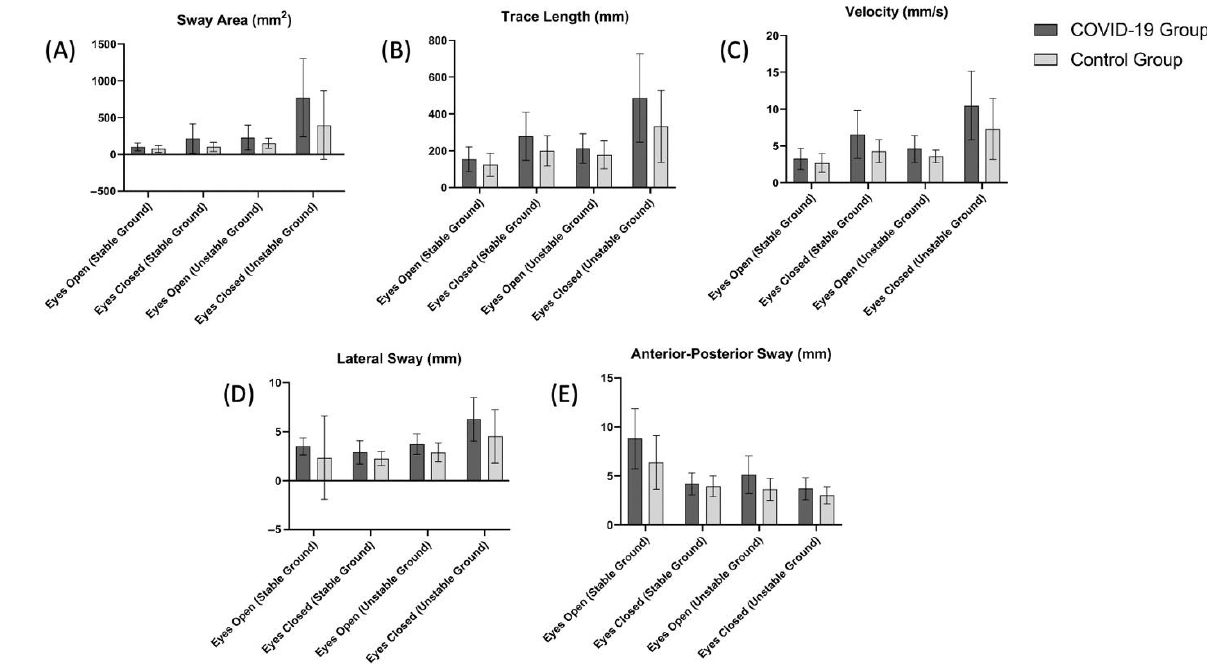
Figure 3. Comparison of ( A ) sway area (eyes open (stable ground), p = 0.049; eyes closed (stable ground), p = 0.009; eyes open (unstable ground), p = 0.038; eyes closed (unstable ground), p = 0.010), ( B ) trace length (eyes open (stable ground), p = 0.11; eyes closed (stable ground), p = 0.01; eyes open (unstable ground), p = 0.11; eyes closed (unstable ground), p = 0.01), ( C ) velocity (eyes open (stable ground), p = 0.14; eyes closed (stable ground), p = 0.003; eyes open (unstable ground), p = 0.01; eyes closed (unstable ground), p = 0.01), ( D ) lateral sway (eyes open (stable ground), p = 0.18; eyes closed (stable ground), p = 0.02; eyes open (unstable ground), p = 0.003; eyes closed (unstable ground), p = 0.01), ( E ) anterior-posterior sway eyes open (stable ground), p = 0.02; eyes closed (stable ground), p = 0.002; eyes open (unstable ground), p = 0.39; eyes closed (unstable ground), p = 0.004) scores between the COVID-19 and control